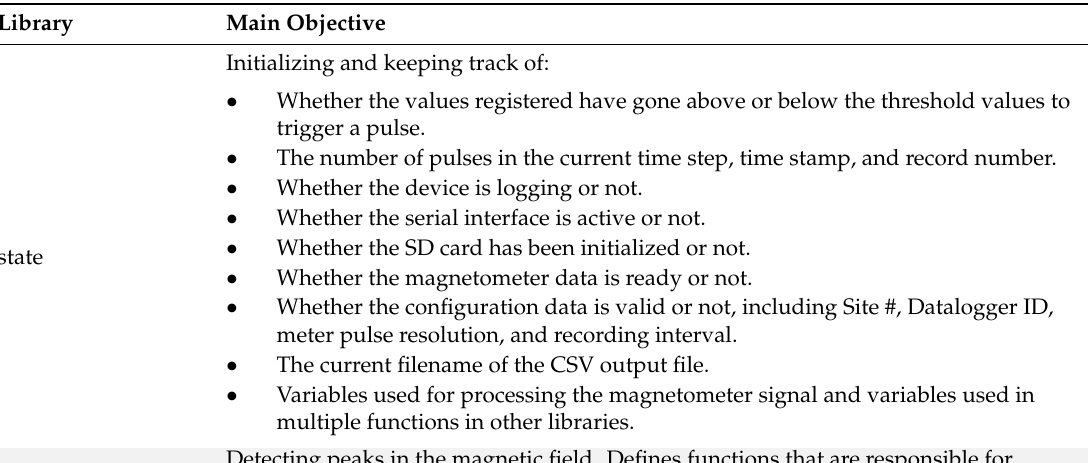
Table 2. Code libraries developed for the CIWS datalogger firmware.